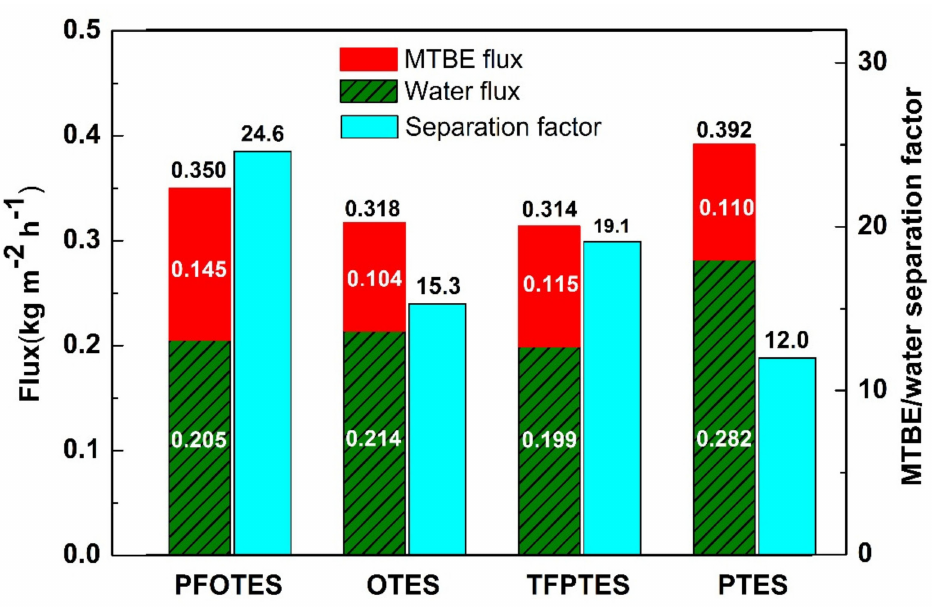
Figure 9. Methyl tert-butyl ether (MTBE) / water separation performance of silica membranes silylated by di ff erent grafting